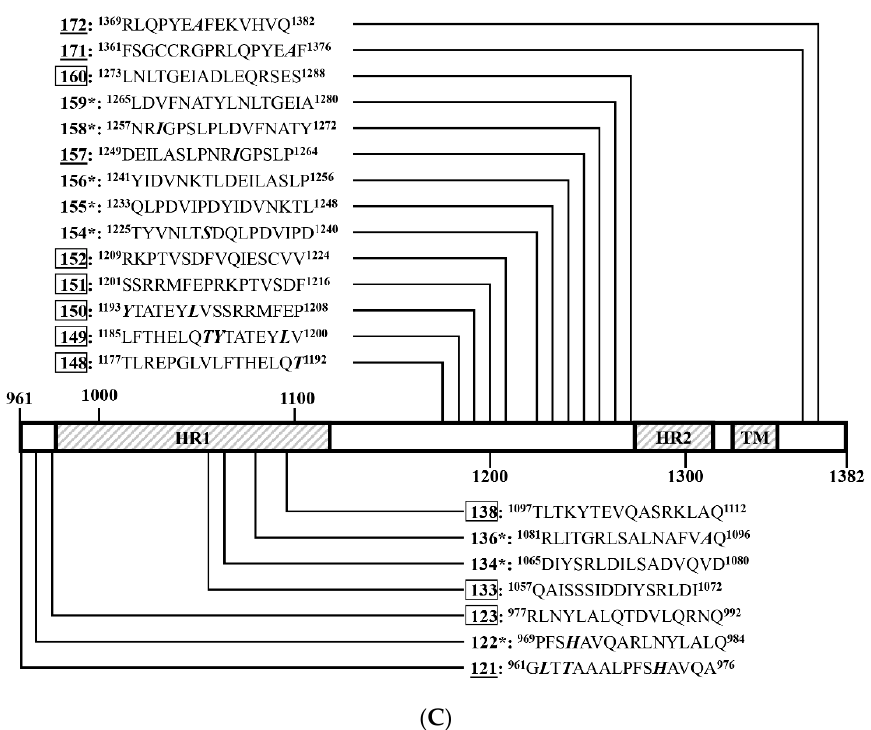
Figure 6. Distribution of positive peptides on SF1 CV777 ( A ), SF2 CV777 ( B ), and SF2 CV777 ( C ). The horizontal bar represents the primary structure of S CV777 protein, of which the functional domains are framed as Figure 1A. Numbers assigned to the 16-mer or 14-mer peptides are the same as in Figure 5. Numbers underlined mark the peptides that are anti-S CV777 serum-positive; Numbers in boxes mark peptides that are anti-S SD2014 serum-positive; Numbers with “*” mark peptides recognized by both anti-S CV777 serum and anti-S SD2014 serum (Co-RecoMers). The positions of each peptide in the S CV777 protein were indicated with superscripts. The arrow showed the boundary of S1/S2.